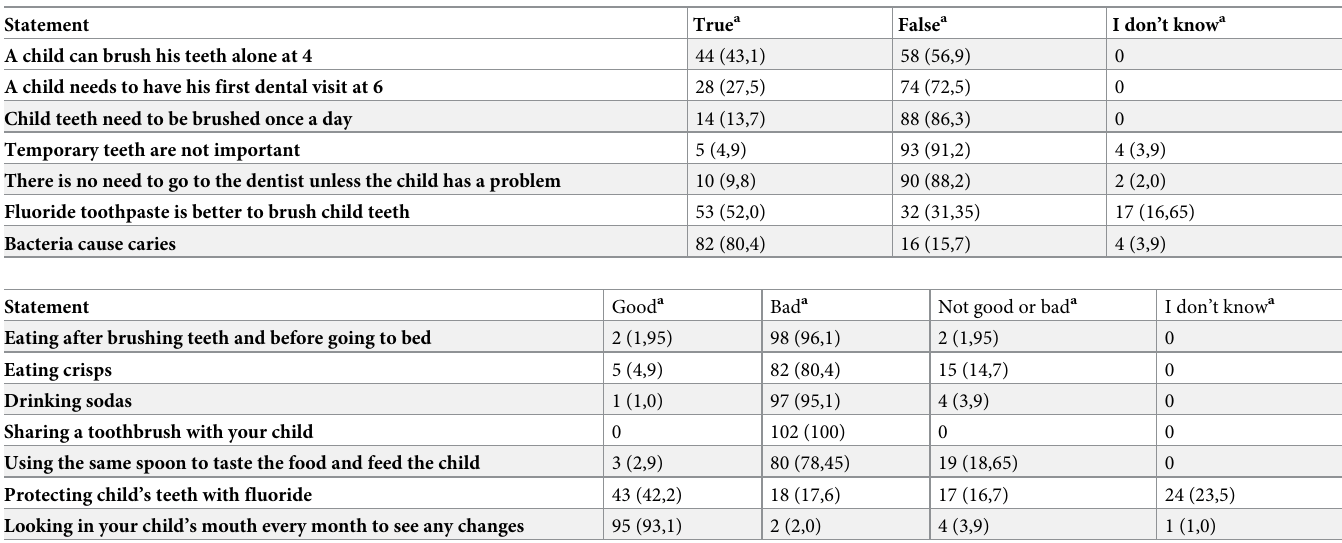
Table 2. Parental oral health knowledge.